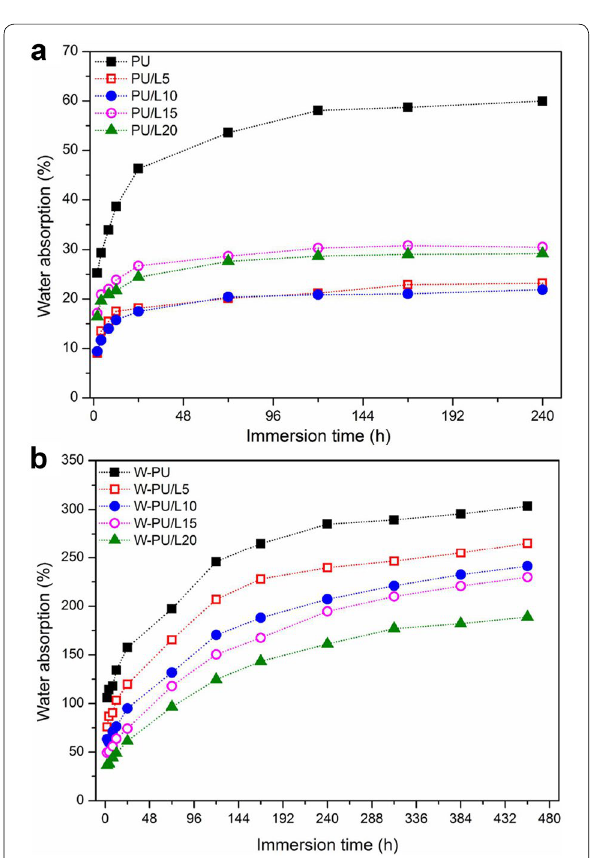
Fig. 7 Water absorption kinetic of a PU series and b W–PU series foams containing varying amounts of